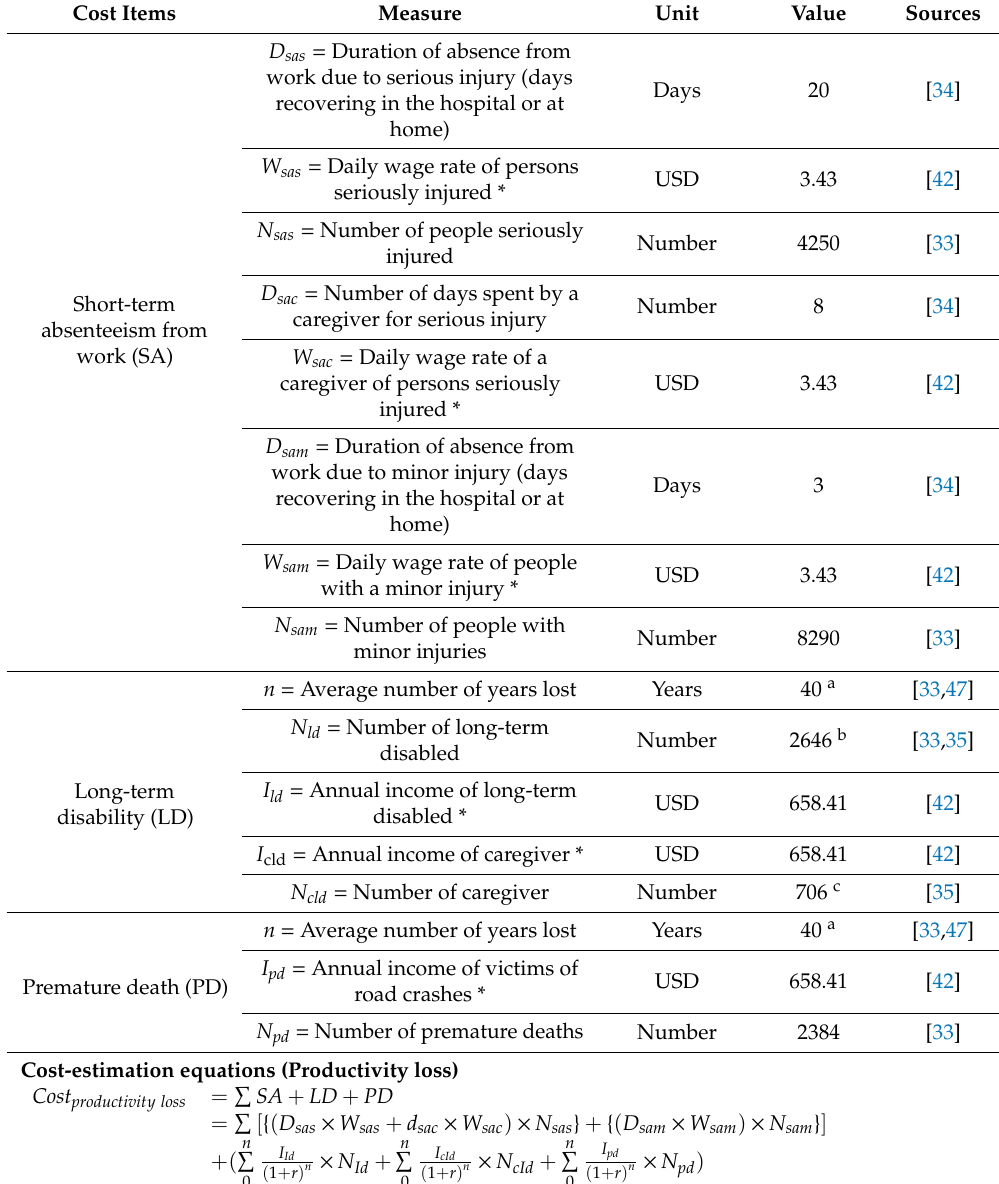
Table 3. Base case values and equations for cost calculation (productivity